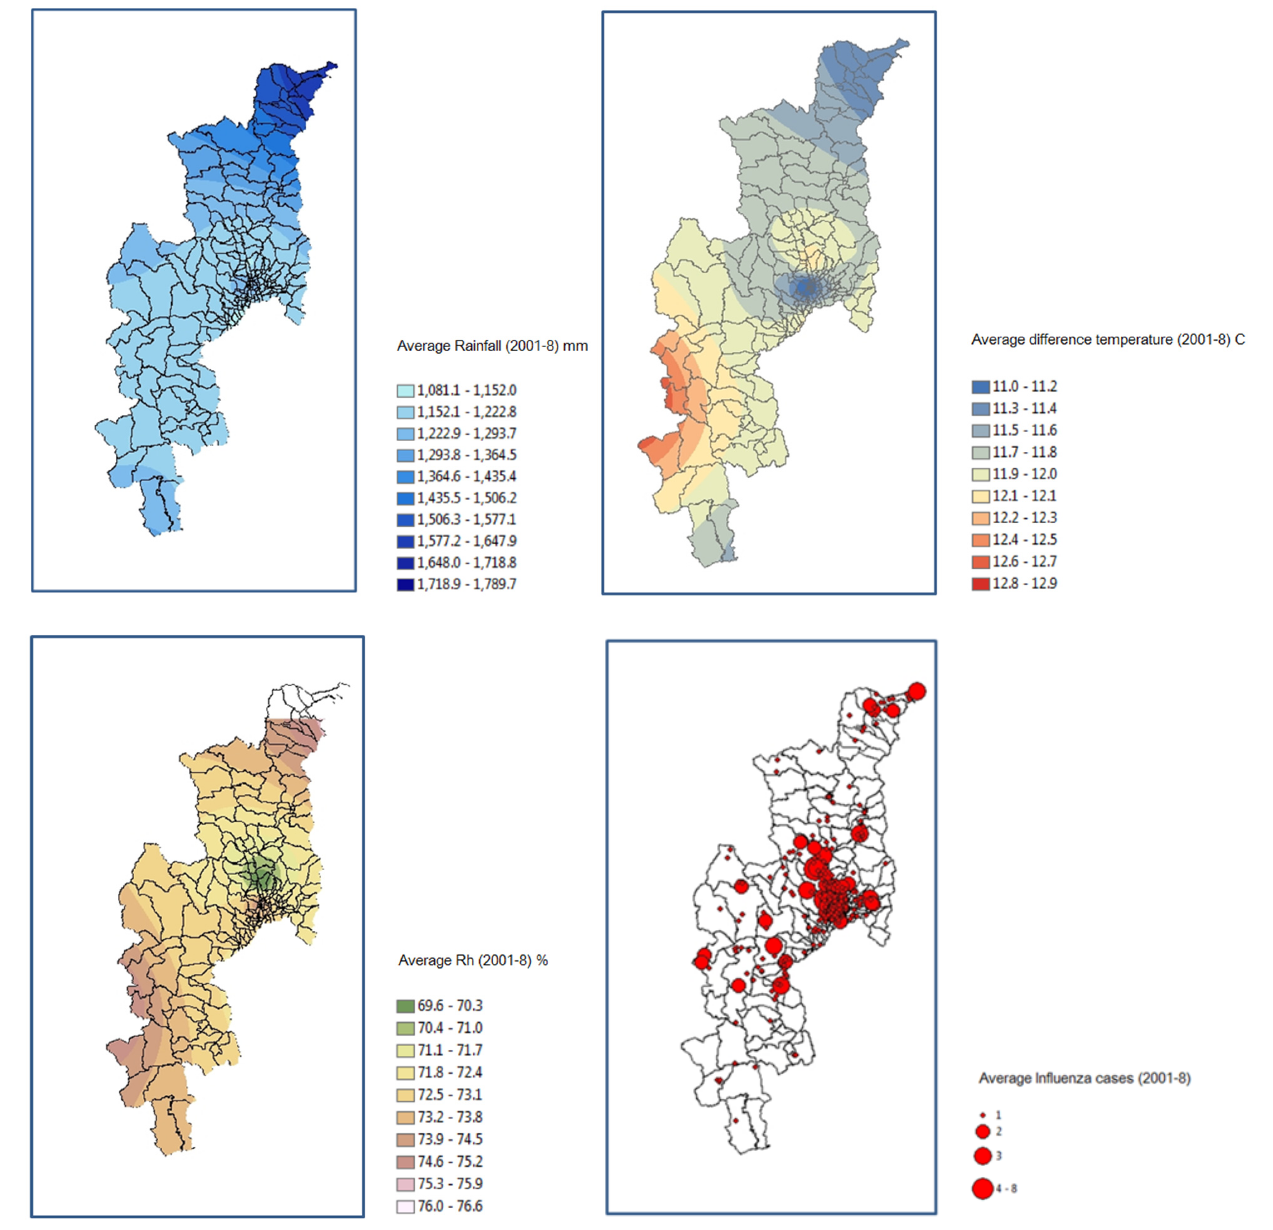
Figure 8. Spatial distribution of climate factors and influenza incidence: Chiang Mai